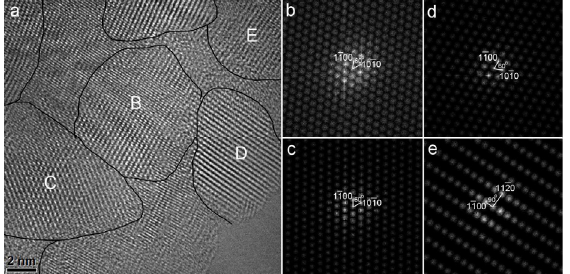
Fig. 7. HRTEM images of the deformed microstructure in transformed bands formed at a strain of 0.30 and a strain rate of 2300 s -1 : (a) (a) HRTEM; (b) SAED in zone B; (c) SAED in zone C; (d) SAED in zone D; (e) SAED in zone